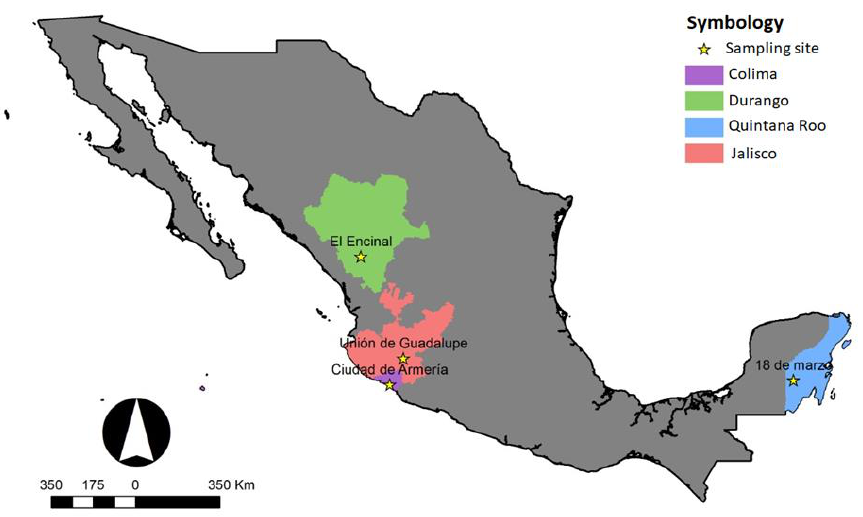
Figure 1. Location of the sites selected to analyze the charcoal production process in Mexico. Table 1. Description of four kiln types, location, and firewood species used for charcoal production.